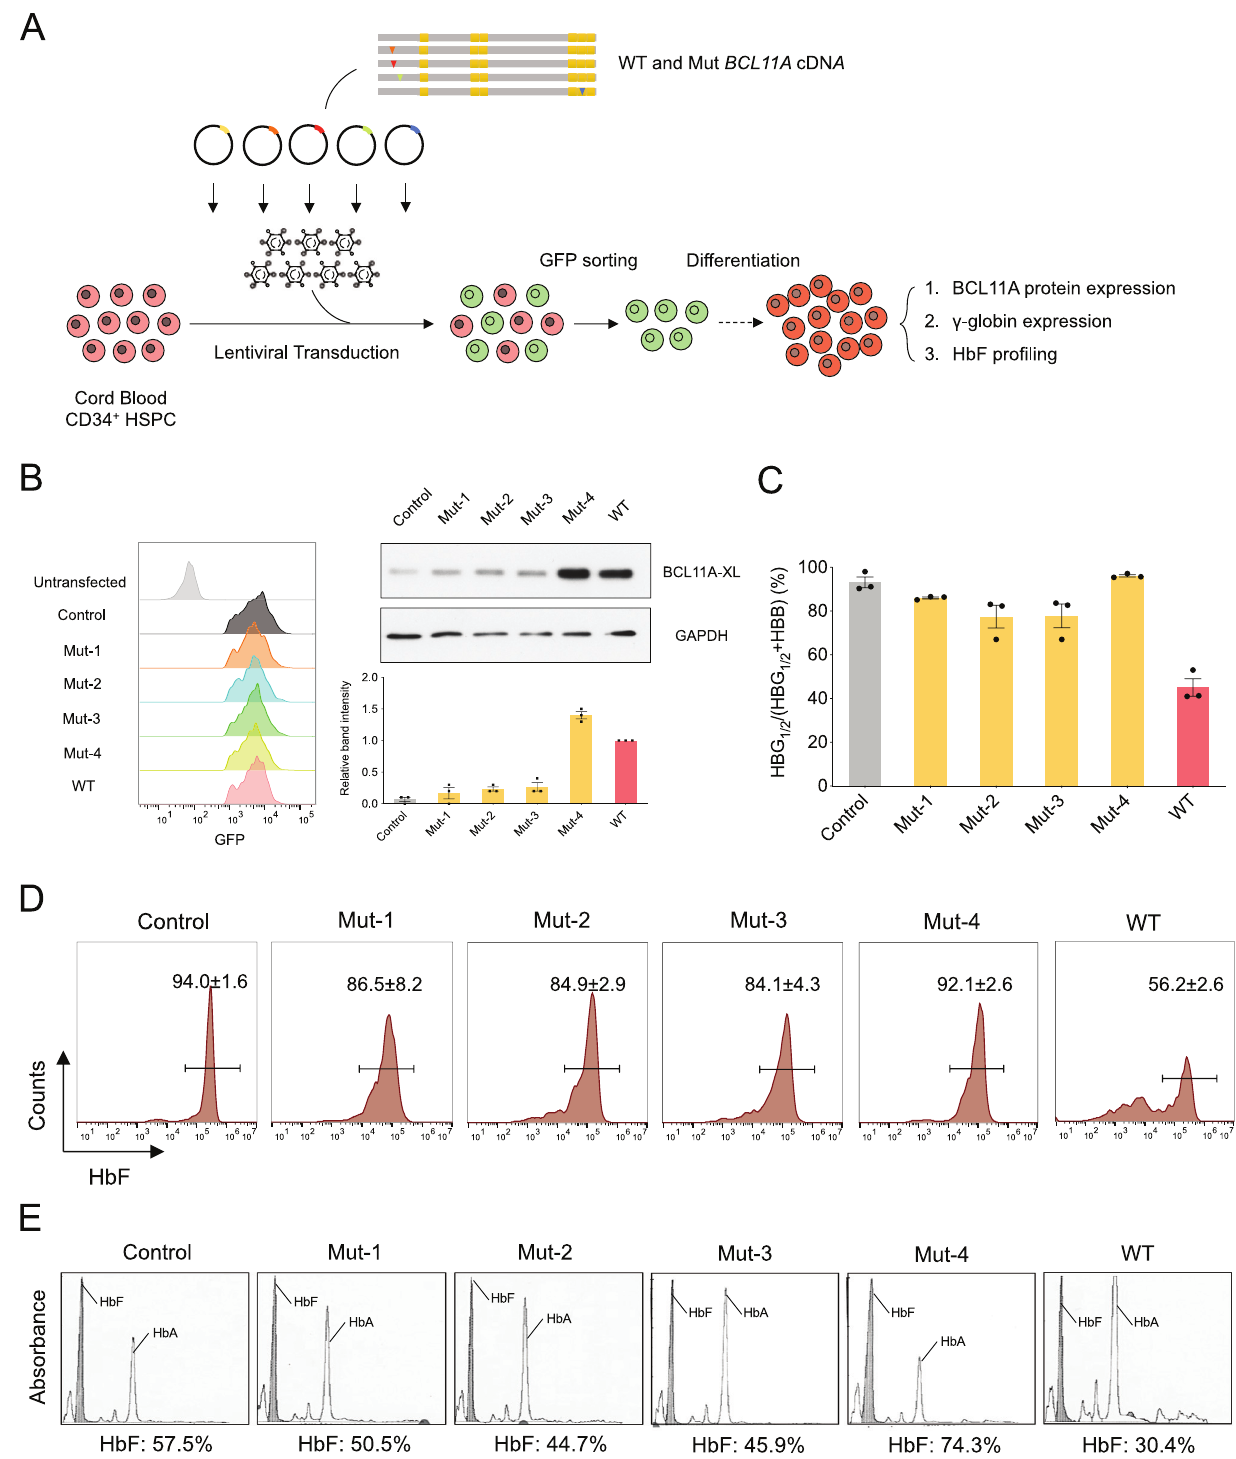
Fig 2. Functional assessment of missense variants impact on HbF silencing. (A) Workflow of exogenous expression of either the wild type or mutant forms of the BCL11A XL in cord blood HSPCs showing lentiviral transduction, GFP sorting, erythroid differentiation and functional analysis. (B) Left panel: A histogram plot shows GFP levels indicating robust and equivalent expression (GFP linked to exogenous BCL11A-XL cDNA). Right panel: A representative western blot and the normalized quantification of BCL11A levels from exogenous cDNA expression in cord blood erythroid cells. BCL11A relative expression levels are normalized with GAPDH expression. Band intensities of all groups are relative to BCL11A-XL WT group. Results are